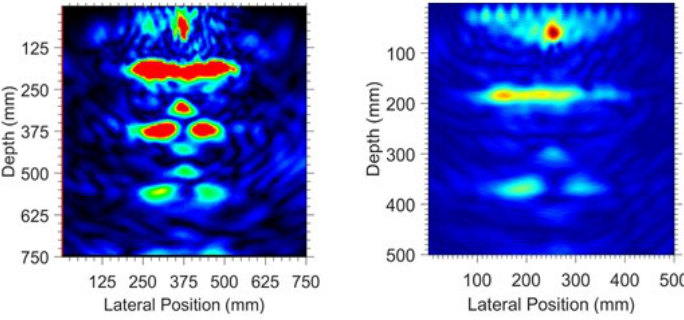
Figure 4. Standard (left) and evaluated (right) images of a CS’ point over the 54 mm-deep dowel.